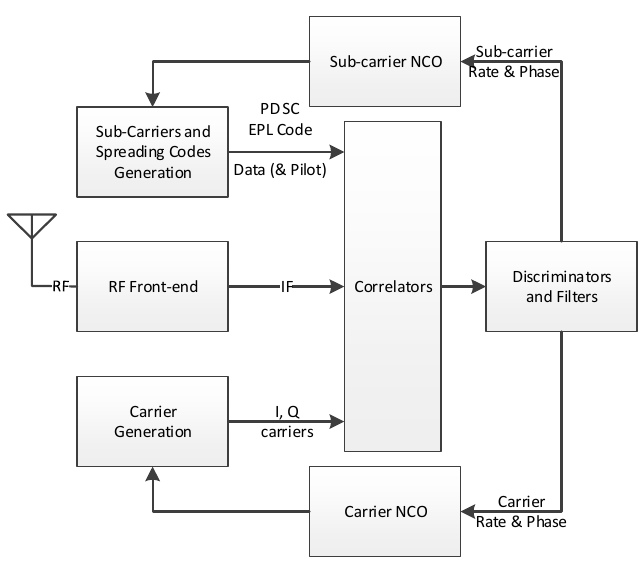
Figure 1. Tracking Channel Simplified Architecture.